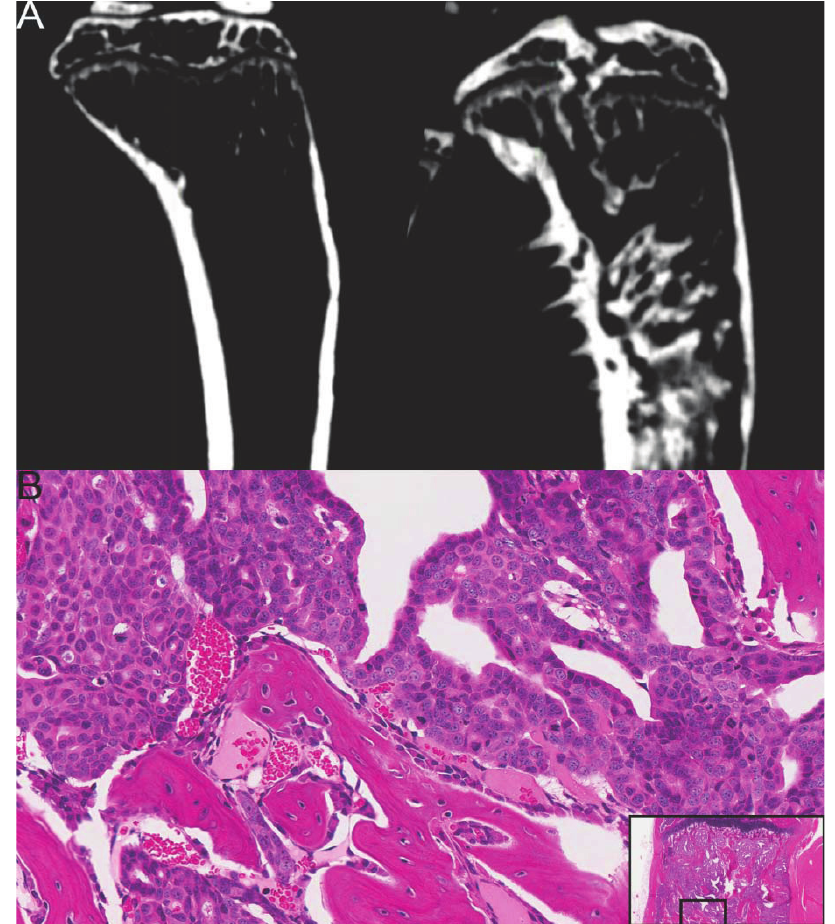
Figure 5. Intratibial Probasco tumor in a nude mouse. ( A ) Micro-computed tomography (µCT) and of a nude mouse tibia injected with Probasco cells (right) and control tibia (left) at three weeks. Tibias in the Probasco-injected group had dramatic new bone formation signified by the increased radio-opacity in the diaphyseal region compared to the control bone; ( B ) Photomicrograph of intratibial tumor. Densely packed large polygonal neoplastic cells formed sheets and irregular glands with surrounding large irregular trabeculae of induced woven bone. Numerous polygonal to cuboidal osteoblasts line the trabecular bone and in some areas there is apposition of the prostate cancer cells to the new woven bone surfaces. Mitotic figures are frequent